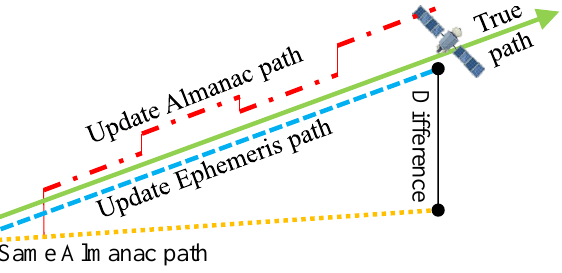
Figure 16. Schematic diagram of